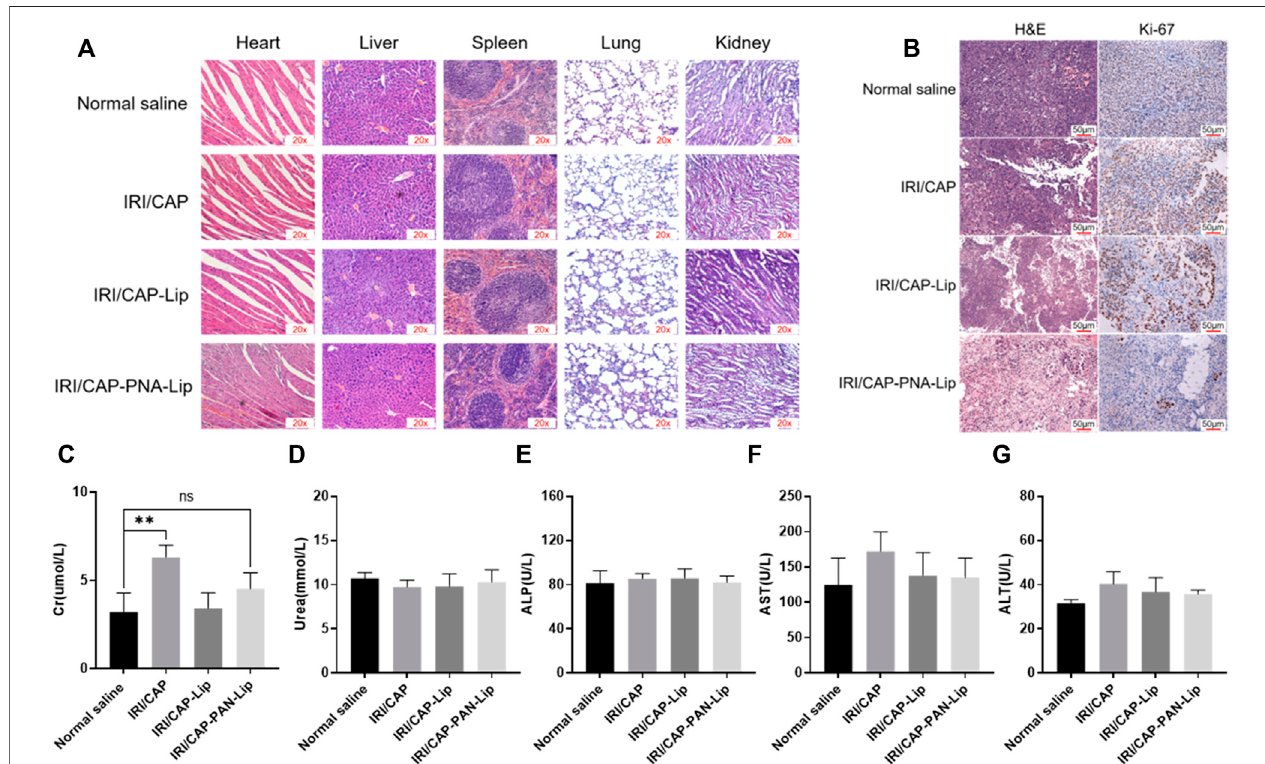
FIGURE 10 | PNA-modi fi ed liposomes had no systemic toxicity and enhanced the antiproliferative ability of drugs on MUC1-positive tumors. (A) H&E staining of vital organs. No signi fi cant pathological changes were observed in any group except for the tumor tissue. 20x (B) Ki-67 staining of tumors in different treatment groups. The plasma biochemical analysis of the tumor-bearing nude mice showed no signi fi cant difference compared with the saline group except for Cr. (C) Creatinine, Cr. (D) Urea. (E) Alkaline phosphatase, ALP. (F) Aspartate aminotransferase, AST. (G) Alanine aminotransferase, ALT. **p < 0.01.